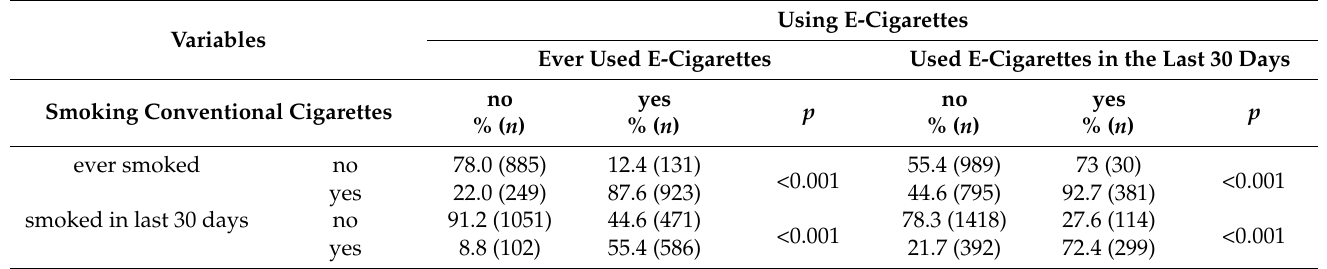
Table 1. Association between using e-cigarettes and smoking conventional